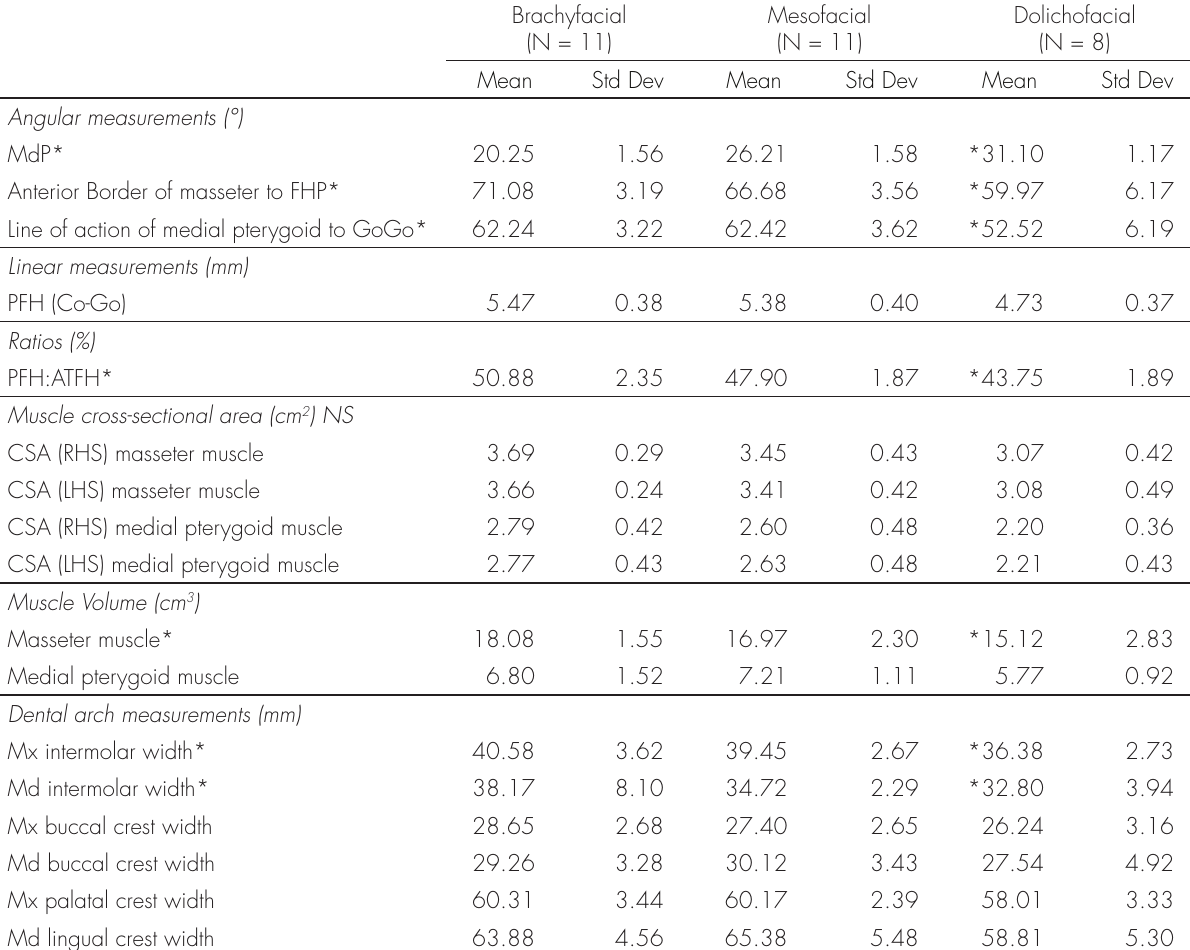
Table V. Means for various measurements in the different vertical facial subgroups.